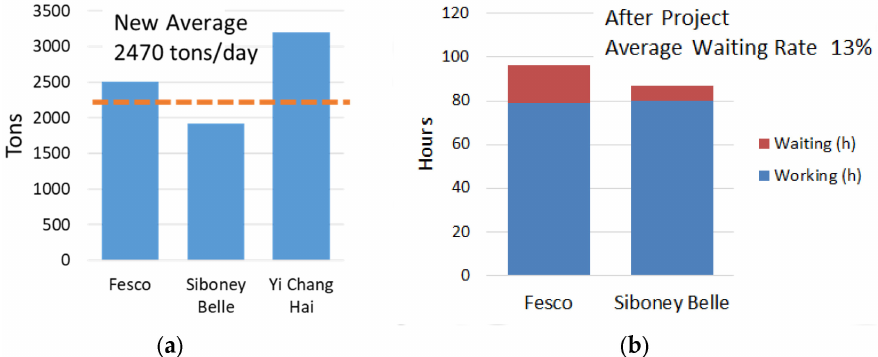
Figure 10. ( a ) Average daily loading rate (after), and ( b ) Average waiting rate (after).